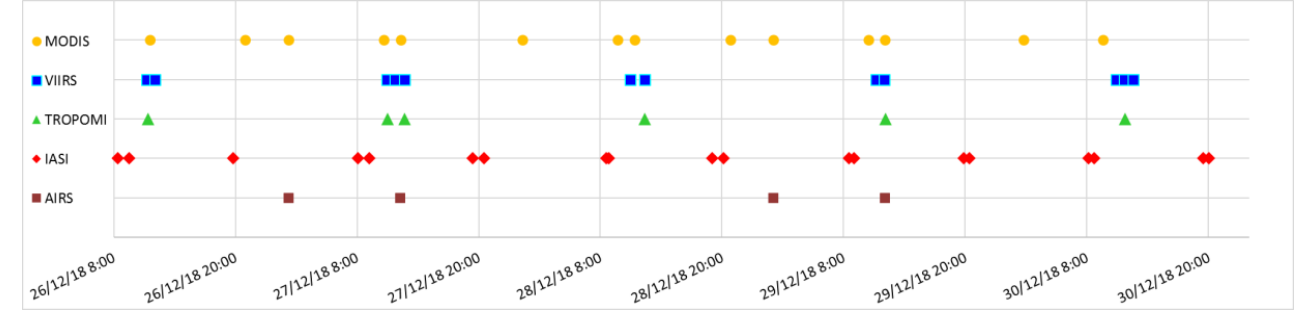
Figure 3. Time distribution of the LEO satellite data processed.